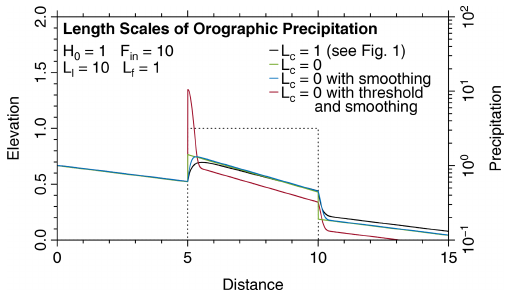
Figure 6. Comparison of the LFPM to the one-component model of Garcia-Castellanos (2007). The parameter values are the same as in Fig.